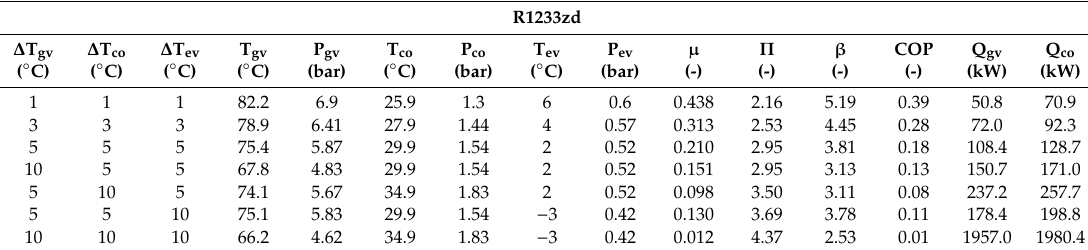
Table A3. Thermodynamic analysis results for R1233zd.